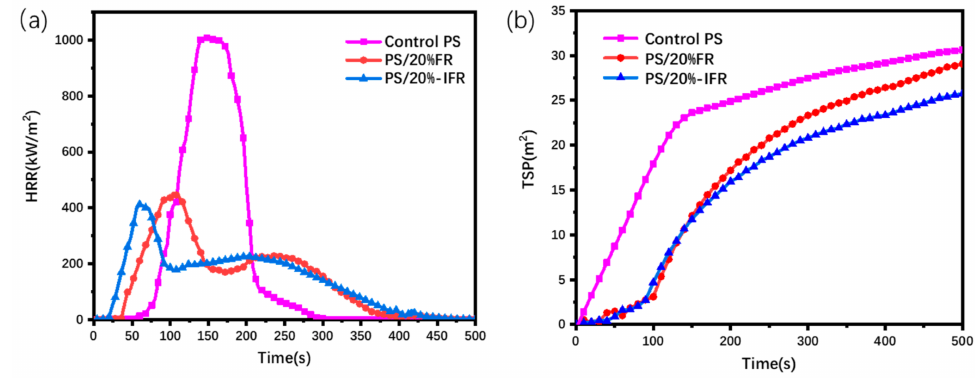
Figure 4. PS and PS composite CONE test curves. ( a ) the heat release rate curve and ( b ) the